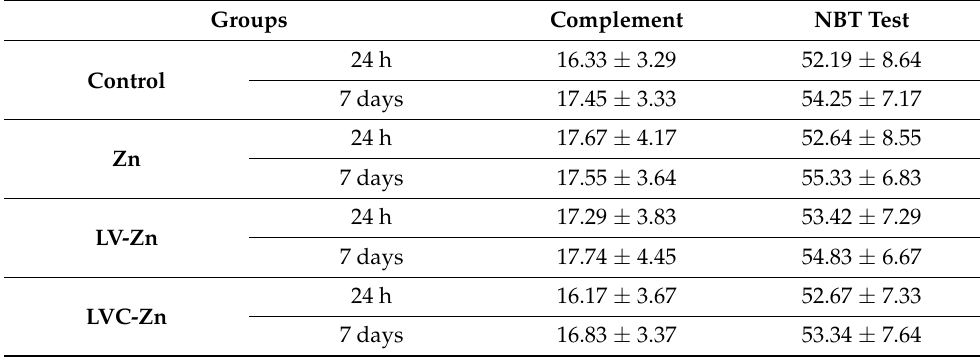
Table 4. The influence of LV-Zn and LVC-Zn on serum complement levels and the NBT test.Values were expressed as mean ± S.D. of mean for 6 rats in a